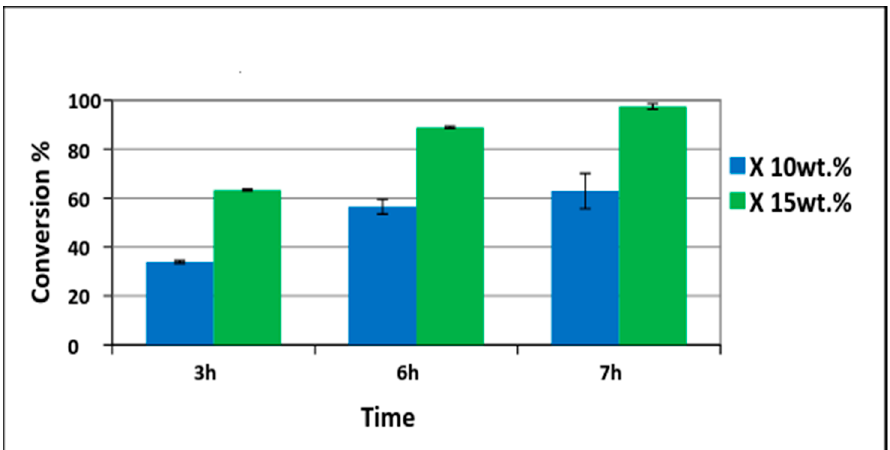
Figure 7. Conversion of phenol using 10 wt% (phenol 1.5g (0.0159 moles) with palladium 0.15 g (0.0014 moles)) and 15 wt% (phenol 1.5 g (0.0159 moles) with palladium 0.225g (0.0021 moles)) of electrospun catalysts.